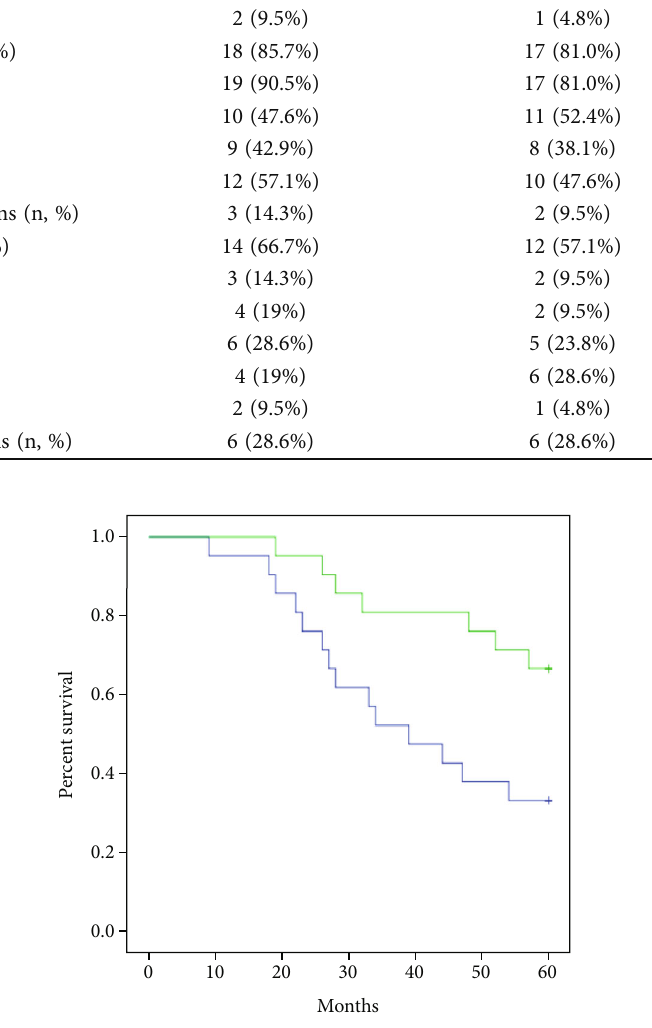
Figure 1: Kaplan-Meier survival curves depicting local recurrence rate among high dose group ( green line ) and low dose group ( blue line ). The curative e ff ect of the study group is better than that of control groupLog Rank =5.528P